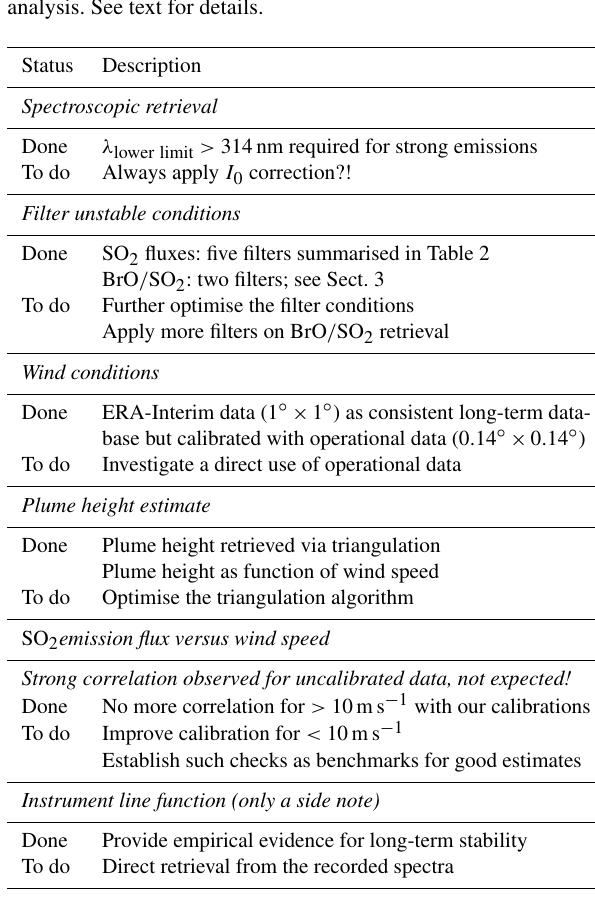
Table 6. Applied and possible future advances in the SO 2 and BrO analysis. See text for